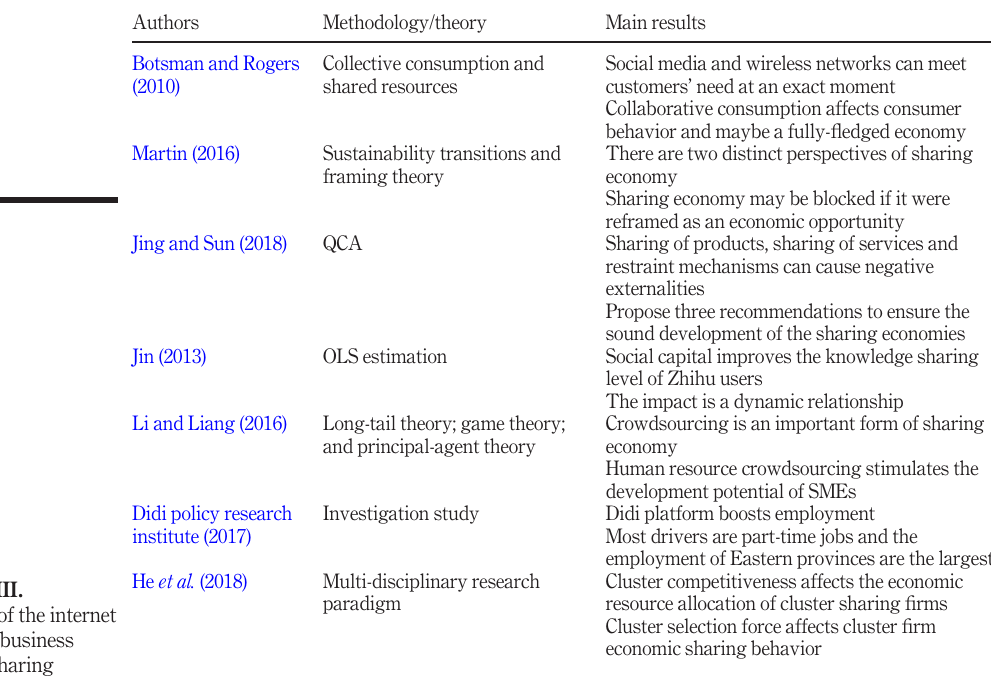
Table III. Effects of the internet on fi rm